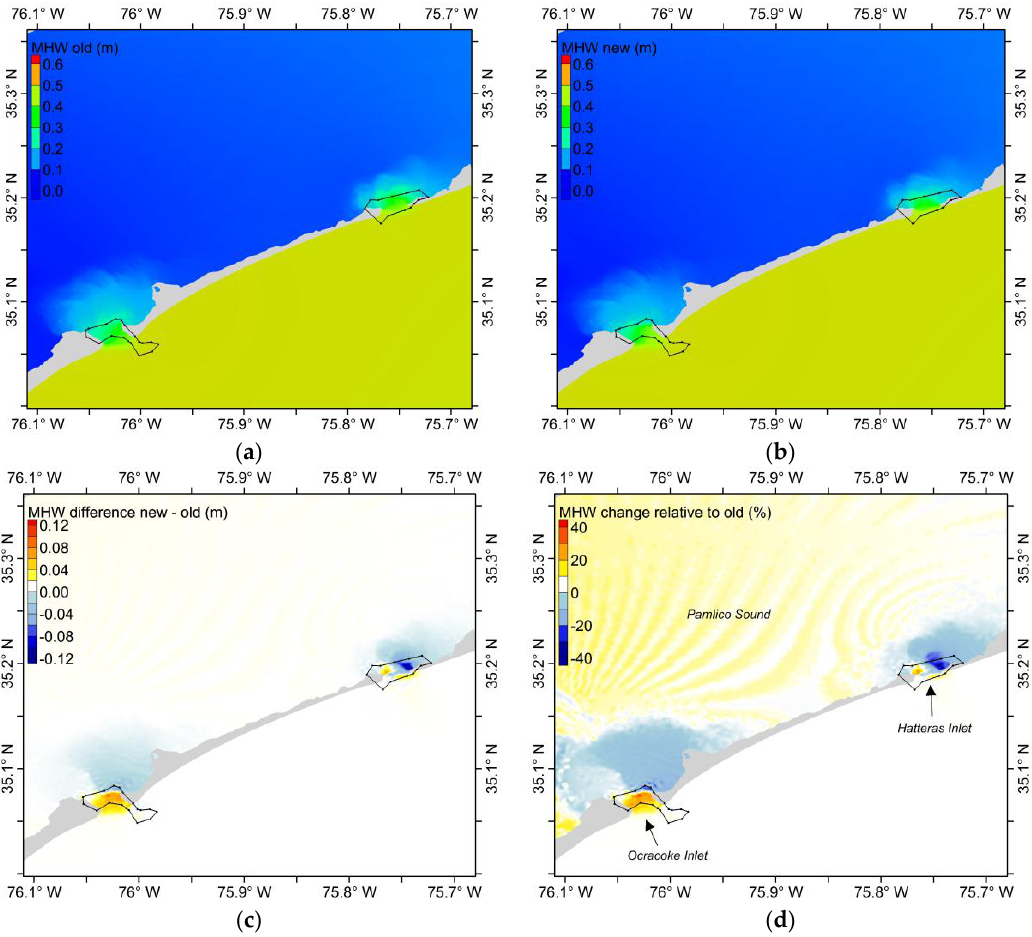
Figure 13. The MHW changes induced by the inlet morphological changes around Ocracoke Inlet and Hatteras Inlet: ( a ) MHW from the old-bathy model; ( b ) MHW from the new-bathy model; ( c ) the MHW difference between the new-bathy model and the old-bathy model; ( d ) the MHW change in percentage relative to the old-bathy model MHW. The black dotted polygons delineate the area with changed bathymetry. J. Mar. Sci. Eng. 2016 , 4 , 79